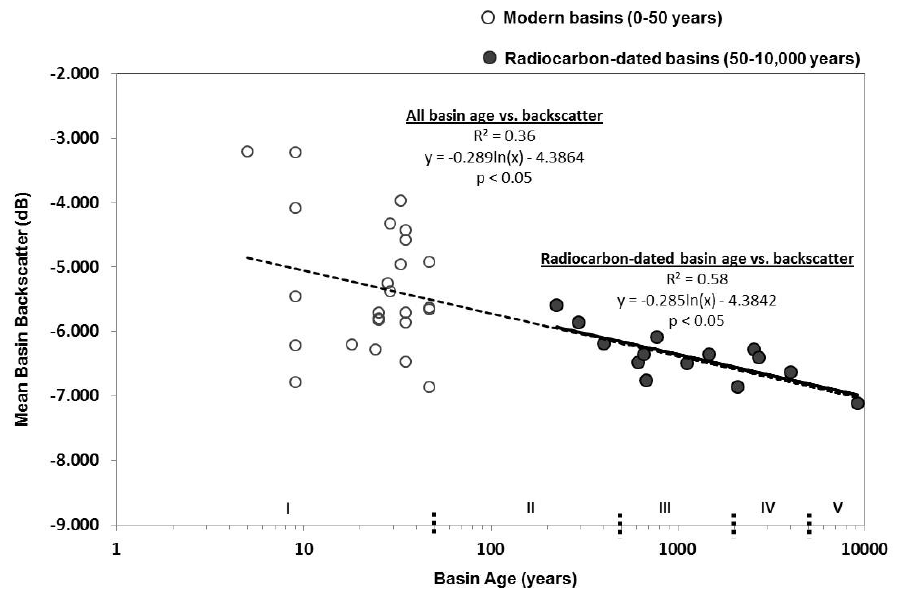
Figure 3. Plot of mean basin backscatter observed on 27 August 2009 against basin age showing a logarithmic relationship for the period of 0–10,000 years and 50–10,000 years. Basin age class is shown as: I. Modern basins; II. Young basins; III. Medium age